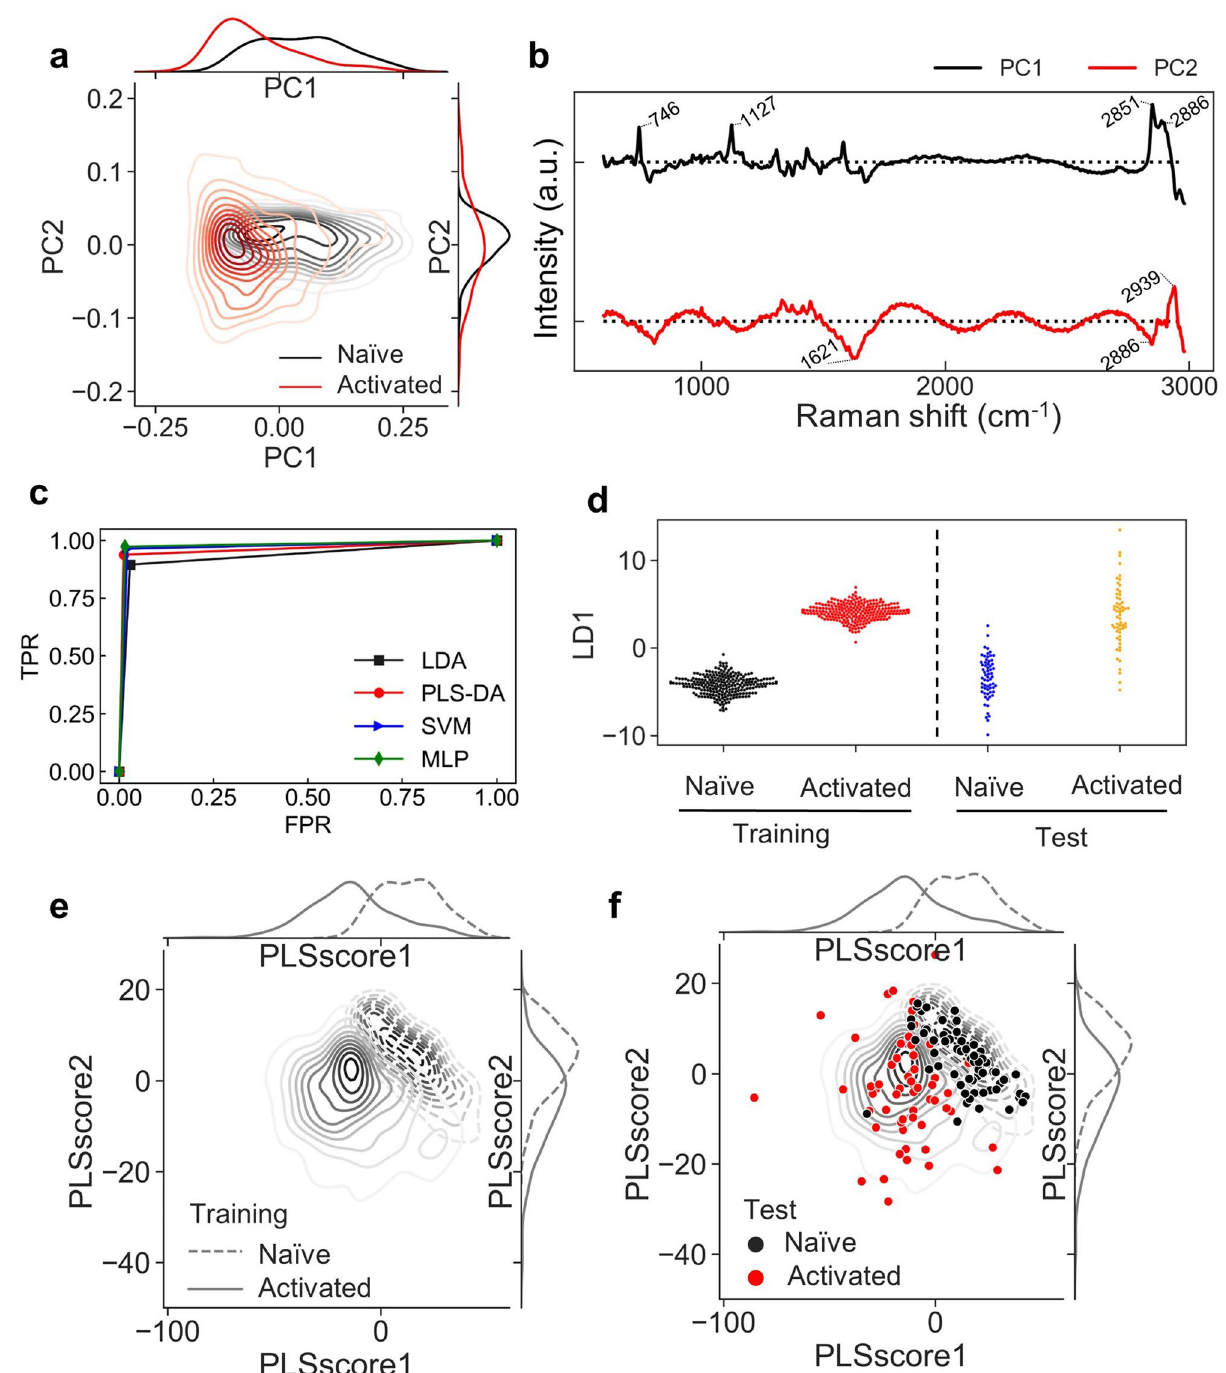
Figure 5. Classification of activated and naïve cells using machine learning. ( a ) Kernel density distribution plot of the first and second principal components for each cell type, which could clearly distinguish between two cell types. On the x- and y-axes, the cell distribution densities for PC1 and PC2 are shown as lines. ( b ) The first two loading vectors calculated by PCA. ( c ) Receiver operating characteristic (ROC) curves of classifiers (LDA, PLS-DA, SVM, and MLP). The X-axis denotes the false positive rate (FPR, 1-specificity), and the Y-axis represents the true positive rate (TFR). ( d ) Swarm plot of LDA score along the first discriminant axis. Each dot represents a single cell. The left side shows training data, and the right side shows test data. ( e ) Kernel density distribution diagram of the first and second PLS scores for the training data set of each cell type (naïve cell shown as dotted line, while activated cells shown as straight line). On the x- and y-axes, the cell distribution densities for PLS score1 and PLS score2 are shown as lines. ( f ) Test data is plotted above the kernel density distribution line of the first and second PLS scores of training data for each cell type (Training data: naïve cells are shown as dotted line, while activated cells are shown as straight line. Test data: naïve cells are shown in black, while activated cells are shown in